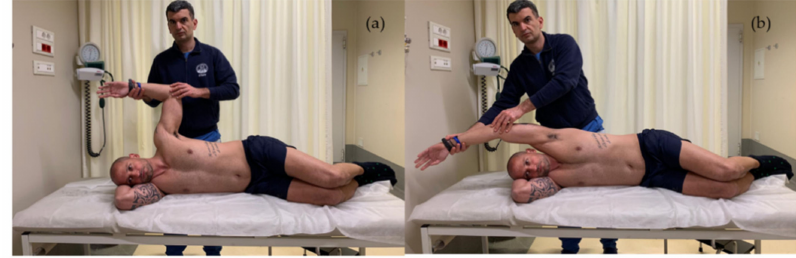
Figure 3. Shoulder horizontal abduction stretching at 90 ◦ ( a ) and 150 ◦ ( b